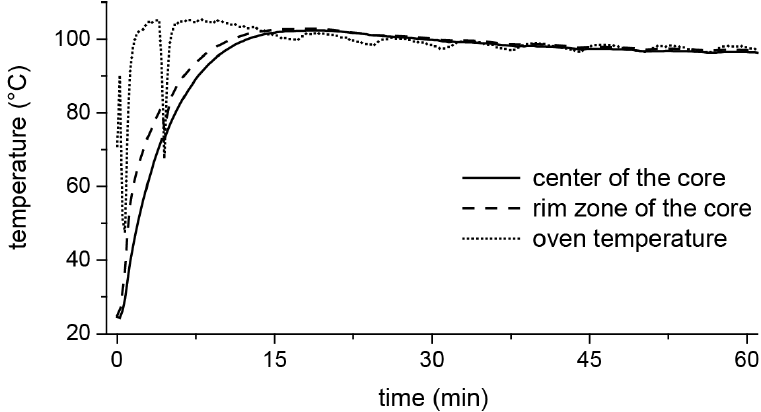
Figure 5. Temporal evolution of the temperature of a core of the same dimensions as micro-CT experiments from the gypsum rock in an oven at 100 °C.